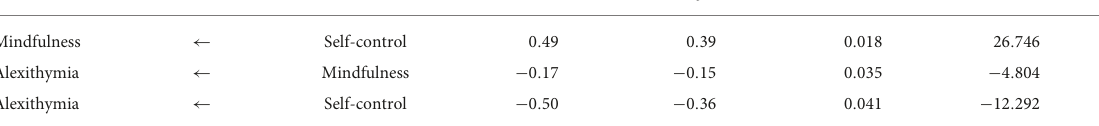
FIGURE2 Forest plot of associate factors of alexithymia.